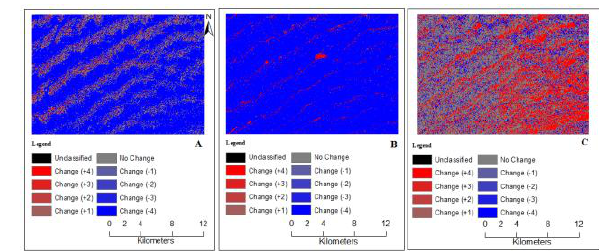
Landsat vs. Worldview: